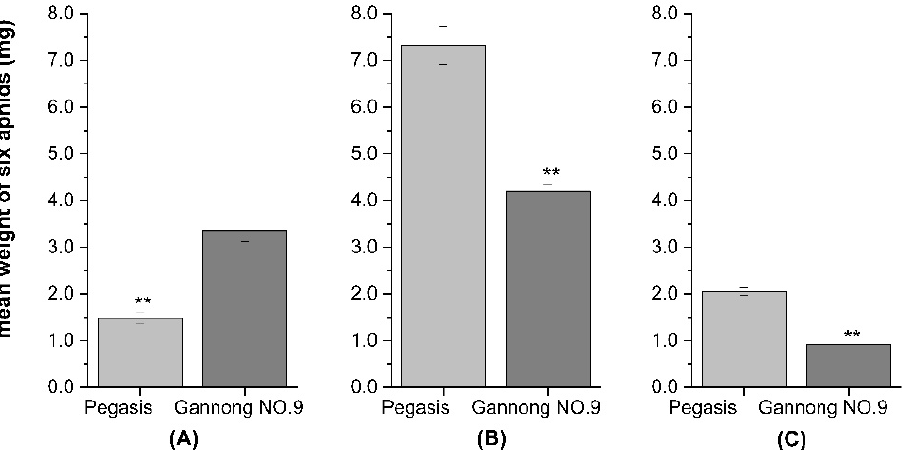
Figure 2. The weight of ( A )cowpea aphid (CPA), ( B ) pea aphid (PA), ( C ) spotted aphid (SAA) on the alfalfa cultivars of Pegasis and Gannong NO.9 (data sourced from Figure 1A–C) (** Indicates that the difference is significant at p < 0.05).